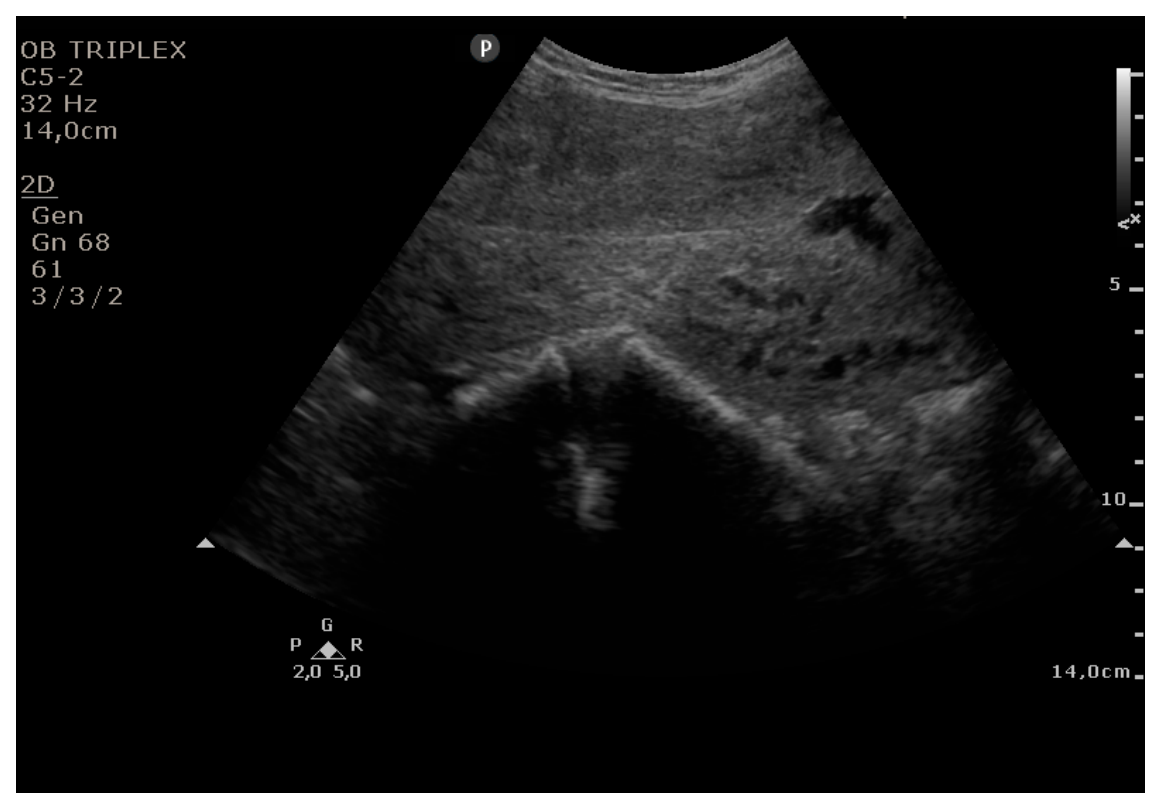
Figure 2. Grade 1: less than one-quarter of the endometrial length occupied by blood or debris.